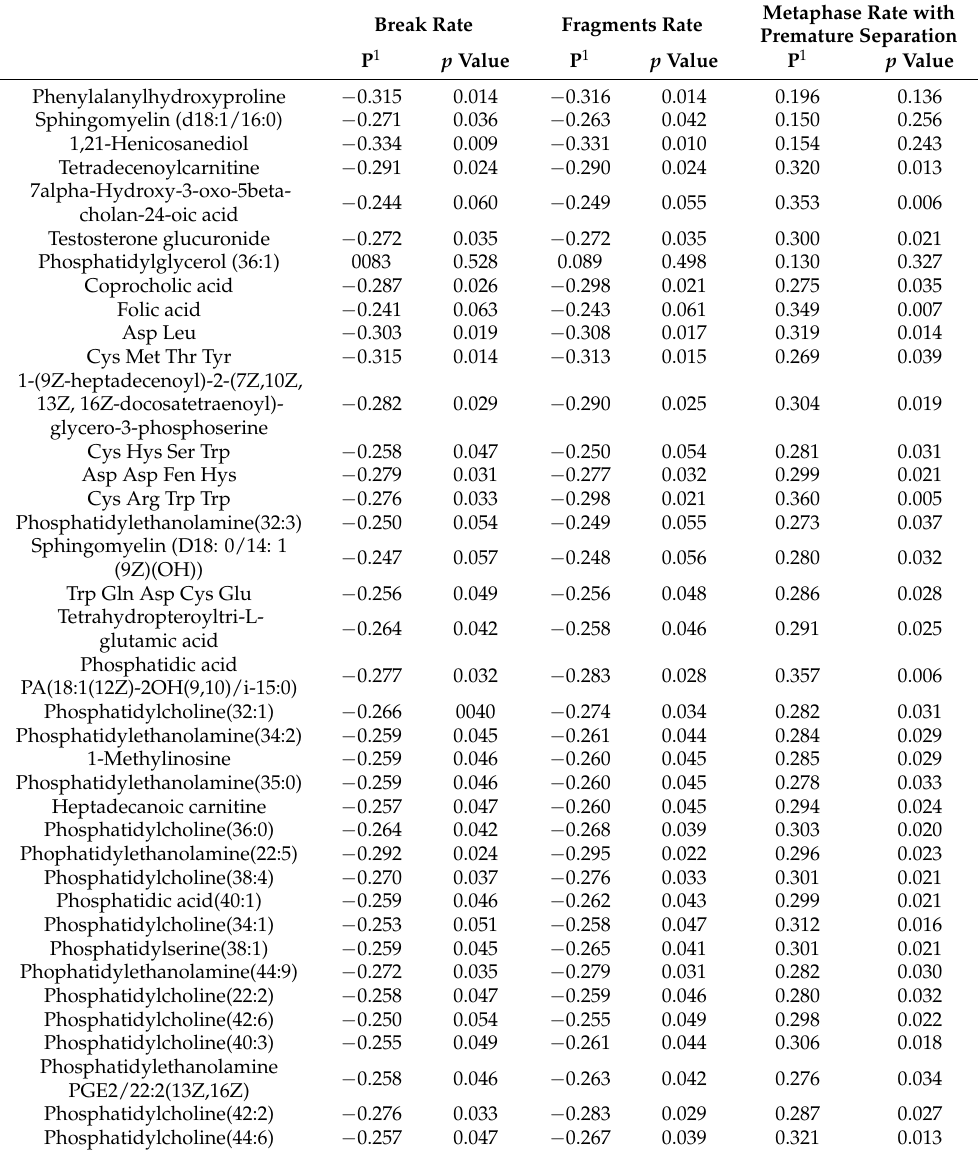
Table 4. Spearman correlation between urinary metabolites and chromosomal